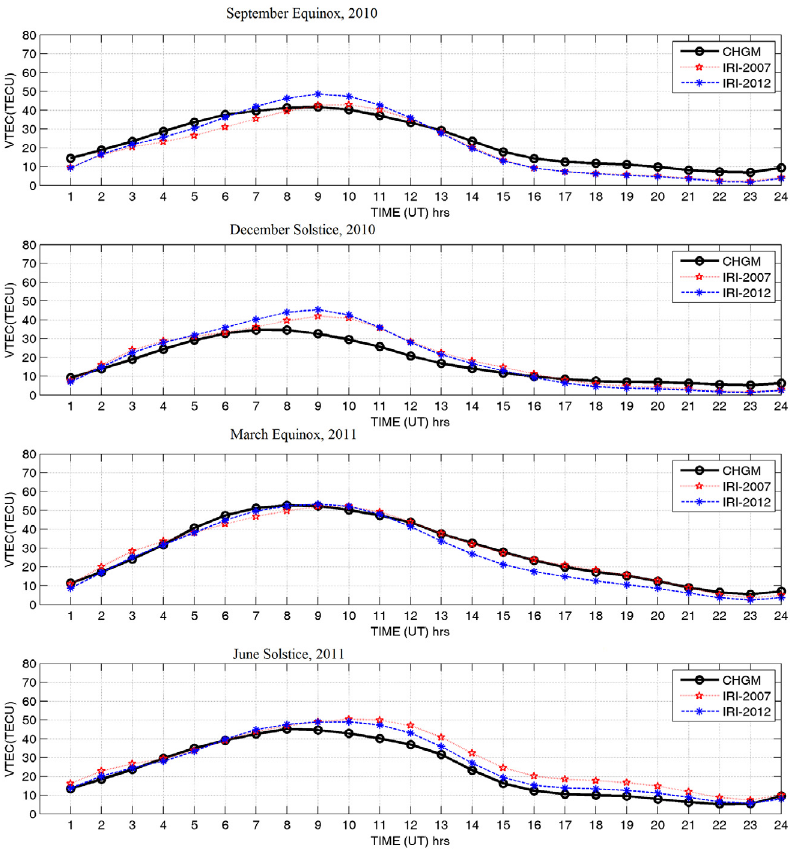
Figure 4. Seasonal mean values of GPS TEC, IRI-2007 TEC and IRI-2012 TEC at CHGM station for the period August 2010 - July 2011.